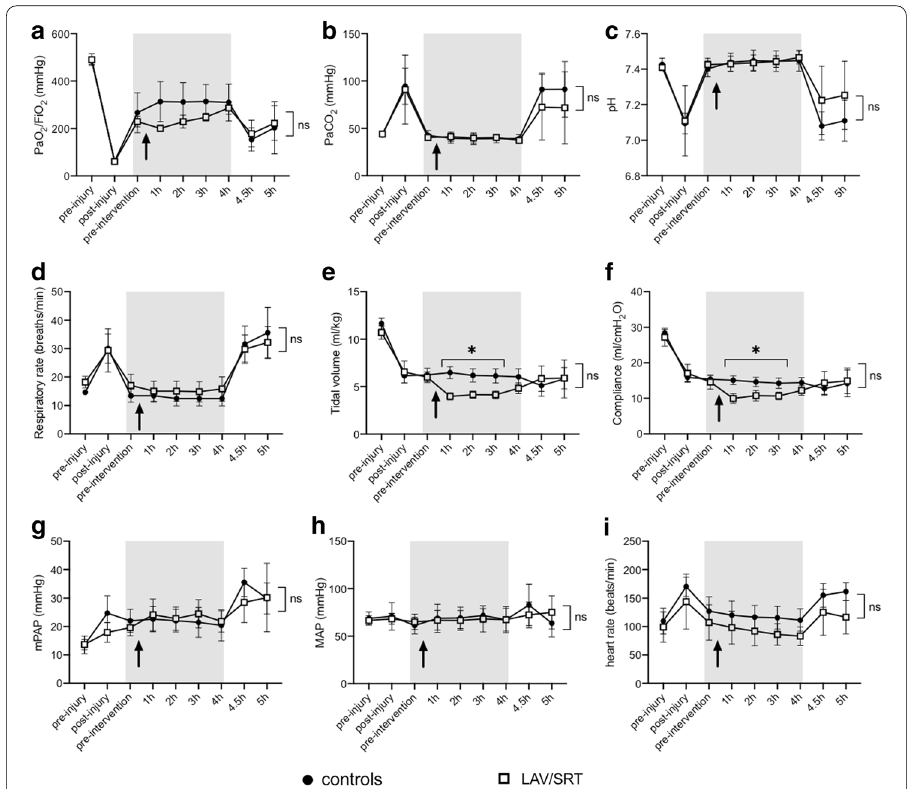
Fig. 3 Lung physiology parameters. Data shown represent means parameters evaluated on ECMO. Black arrow represents time at which intervention was performed. a PaO 2 / FiO 2 (mmHg); b PaCO 2 ; c pH; d respiratory rate; e expired tidal volume; f compliance; g mean pulmonary arterial pressure (mPAP); h mean systemic arterial pressure (MAP); i heart rate. Two-way ANOVA for repeated measures: * p < 0.05 controls vs